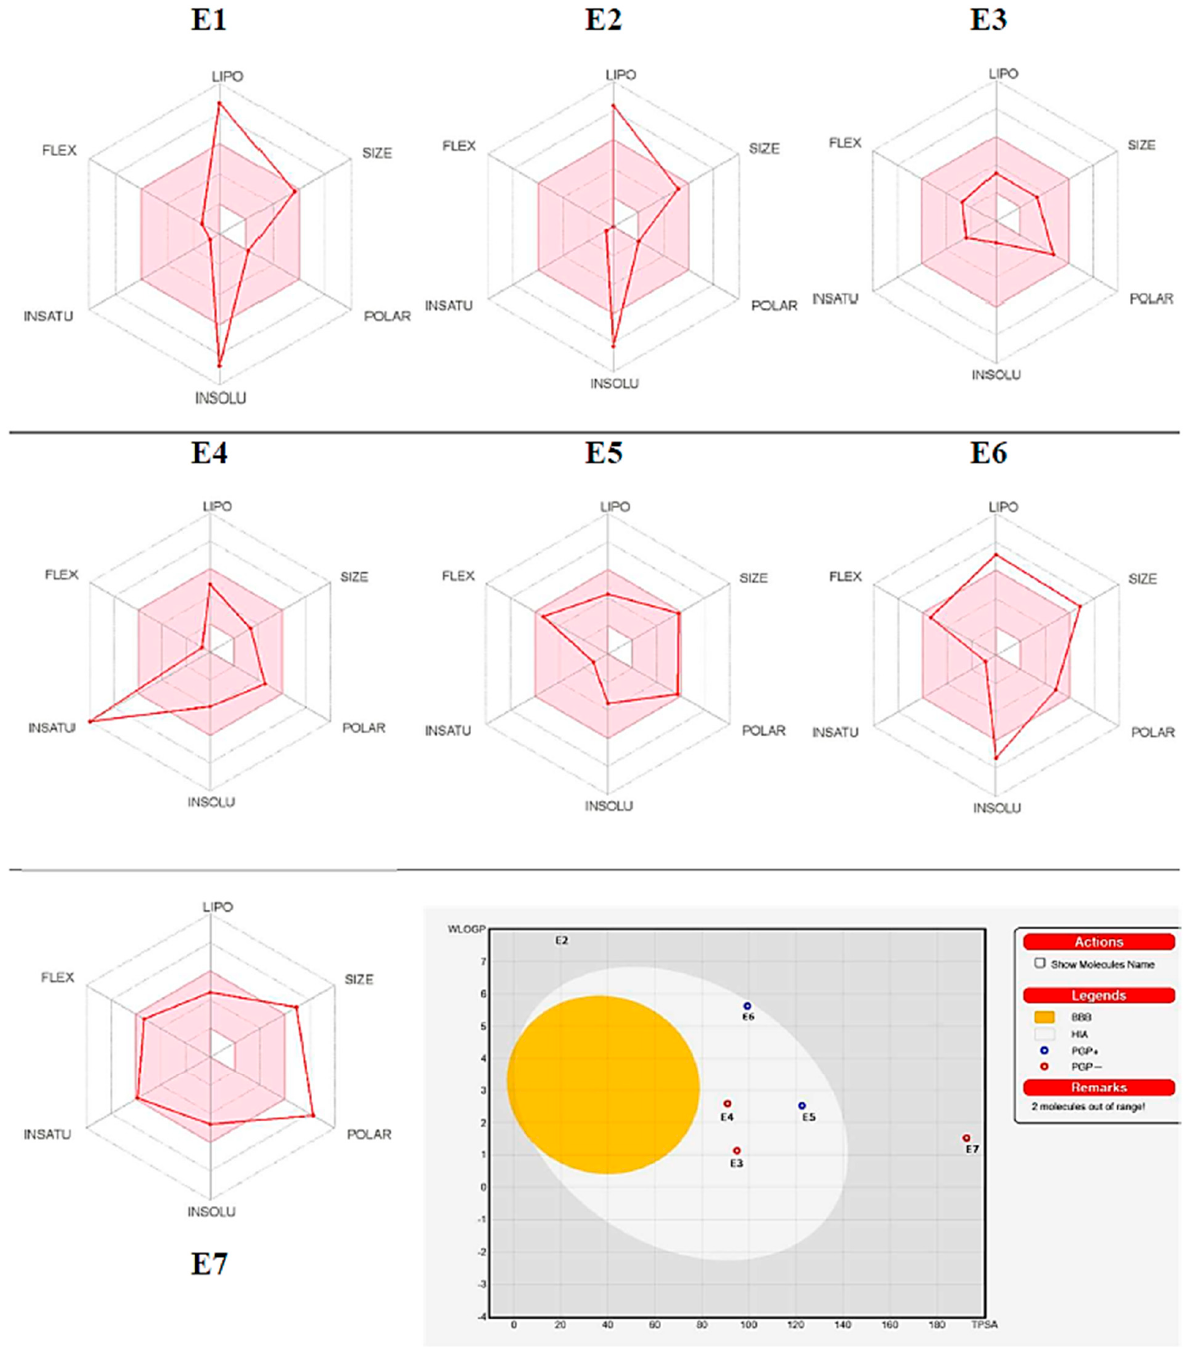
Figure 4. Bioavailability radar representations and predicted BOILED ‐ Egg diagram of